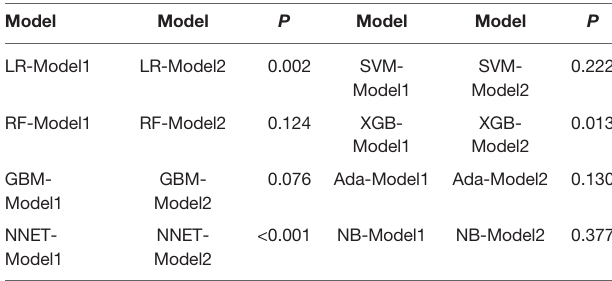
TABLE 4 | Delong test of